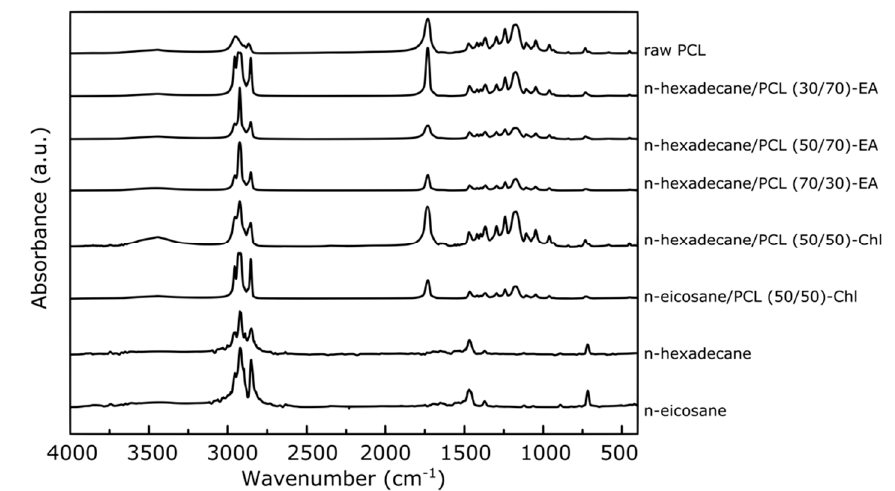
Figure 2. The fourier transform infrared spectroscopy (FT-IR) spectra of n -eicosane, n -hexadecane, neat PCL microsphere and a series of mPCM obtained from different conditions.